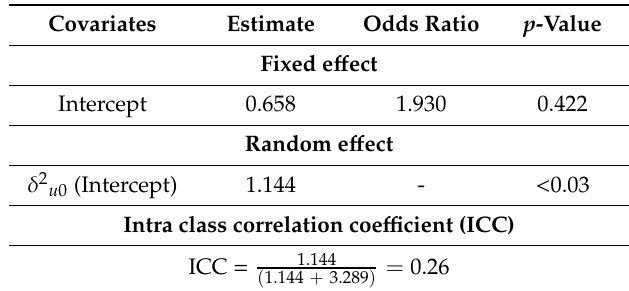
Table 1. Maximum likelihood estimates of multilevel empty model with intra class correlation coe ffi cient (ICC).